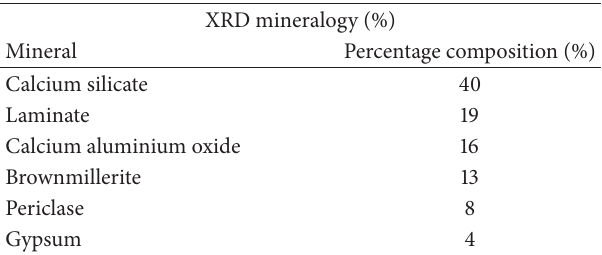
Table4:MineralcompositionofordinaryPortlandcementbyXRD.